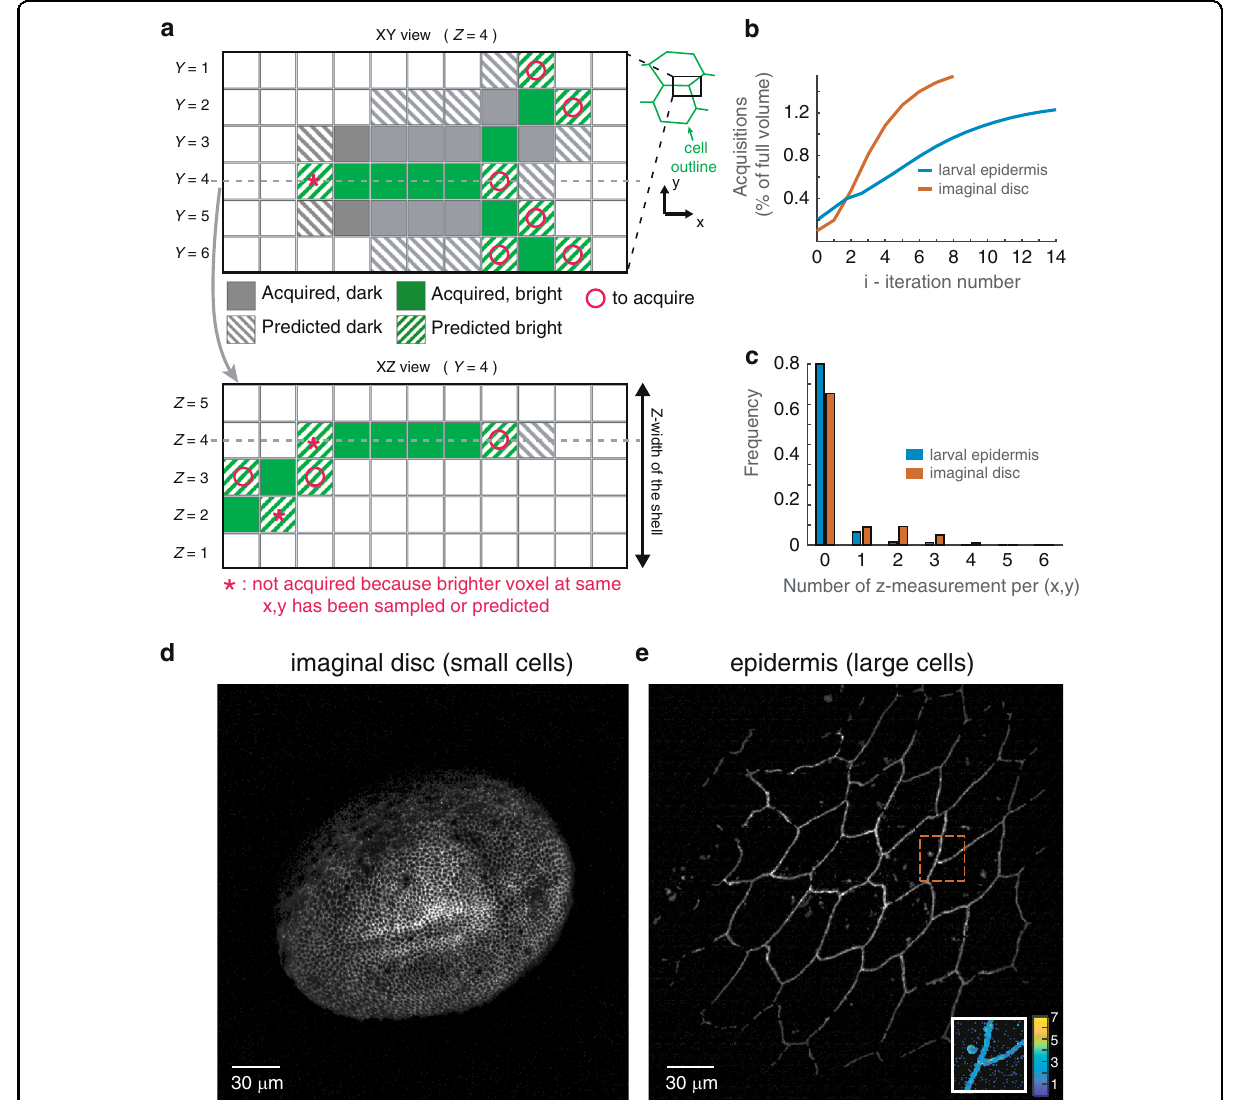
Fig. 3 Propagative scan within the estimated shell. a voxel-level schematic of the algorithm. Using the information from previously acquired voxels (which may be bright or dark voxels), a prediction (hatched coloring) based on the nearest neighbors is made for neighboring pixels in each layers of the shell, and at a distance β = 1 in this example. Two corresponding XY and XZ sections are shown. The signal will be acquired only in the voxels that are predicted to be bright (o). Moreover, on the XZ section, voxels that are predicted to be bright, but for which a brighter voxel has already been acquired or predicted are not sampled (*). b Number of acquisitions as a function of iteration number. c Number of acquisitions performed along z (including the initial pre-scan) for each x , y using the propagative imaging ( β = 1 pixel): no acquisitions have been performed for more than 75% of the x , y coordinates in the case of the small imaginal disc cells and 90% for the large epidermis cells. d , e Maximum intensity projection of the shell at the end of the propagative imaging for the imaginal disc ( d ) and the epidermis ( e ). An inset in ( e ) maps the number of acquisitions performed along z for a small region of interest (outlined in red in the main image). Junctions and endocytic vesicles are fully sampled, while the rest is only sparsely